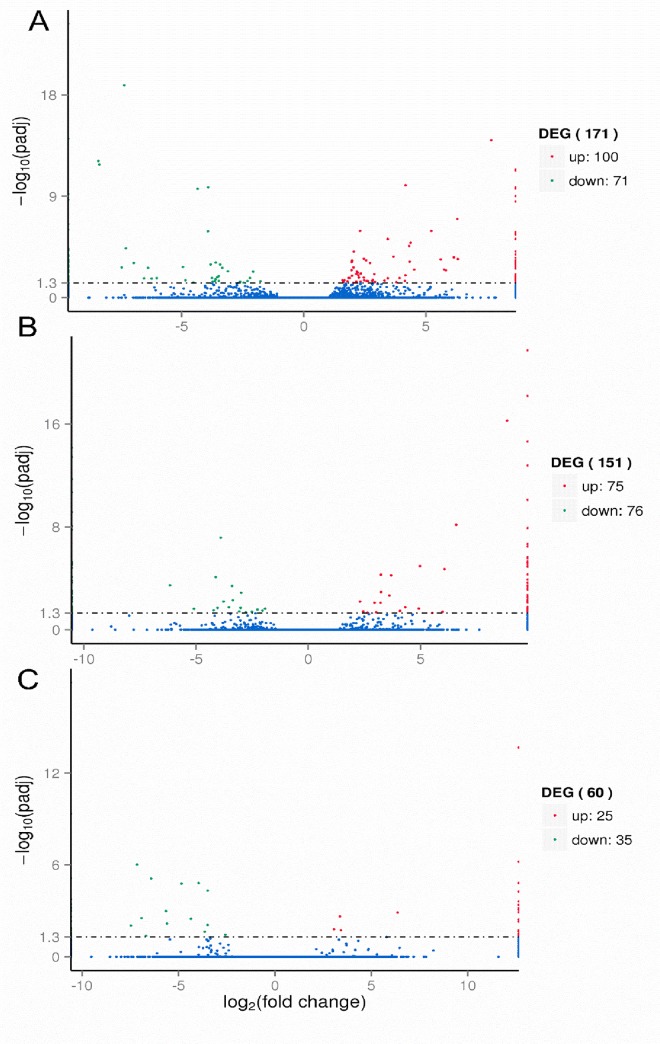
Volcano plots of Differentially Expressed gene sets across three distinct groups (A) IT15vsCT15 (B) IT30 vsCT30 (C) IT45vsCT45. The x-axis shows the fold change in gene expression between different samples, and the y-axis shows the statistical significance of the differences. Statistically significant differences are represented by red dots.